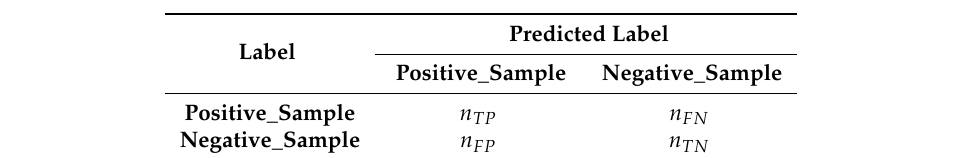
Table 2. Confusion matrix.